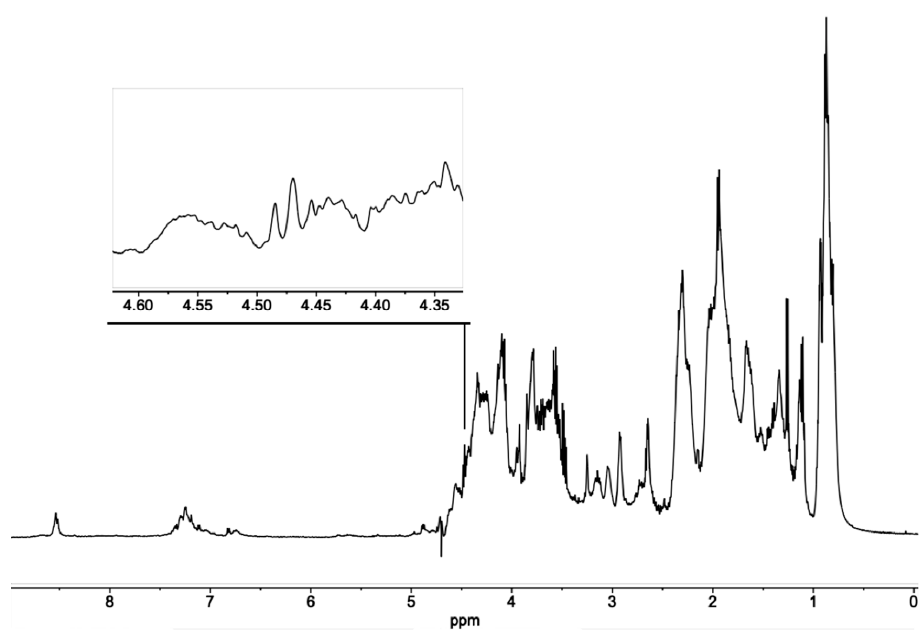
Figure 8. Water-suppressed 1 H NMR spectrum of melanoidins from DL. The expansion shows the anomeric resonance of a β -D-galactopyranosyl residue at the non-reducing end of a lysine-linked lactose molecule.